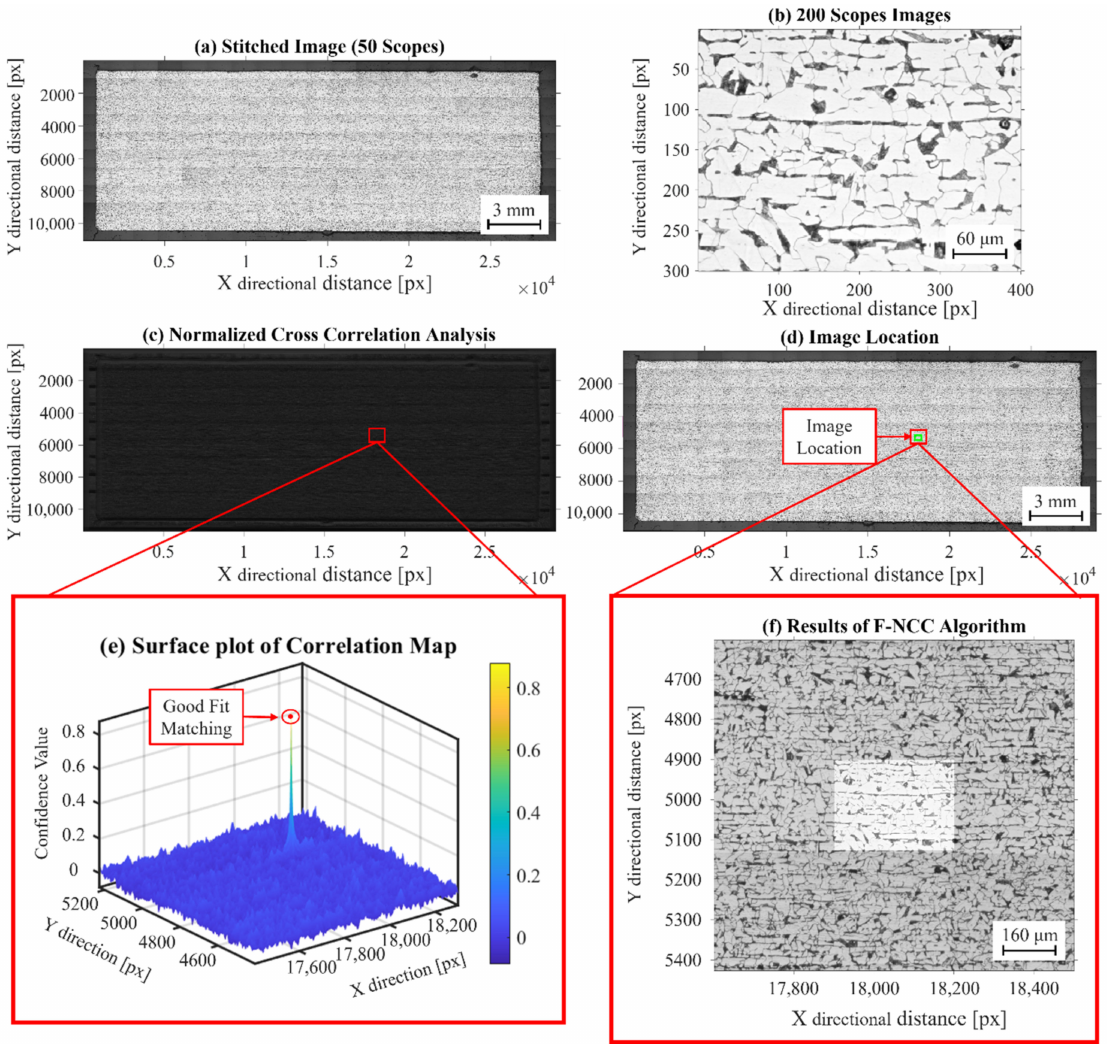
Figure 6. Fast normalized cross-correlation (f-NCC) algorithm for grain matching: ( a ) reference image: stitched 50-scope, ( b ) target image: 200-scope, ( c ) normalized cross-correlation analysis, ( d ) plot of target image location on the reference image, ( e ) surface plot of correlation map, and ( f ) stacking analysis of 200-scope image (bright) on stitched 50-scope image